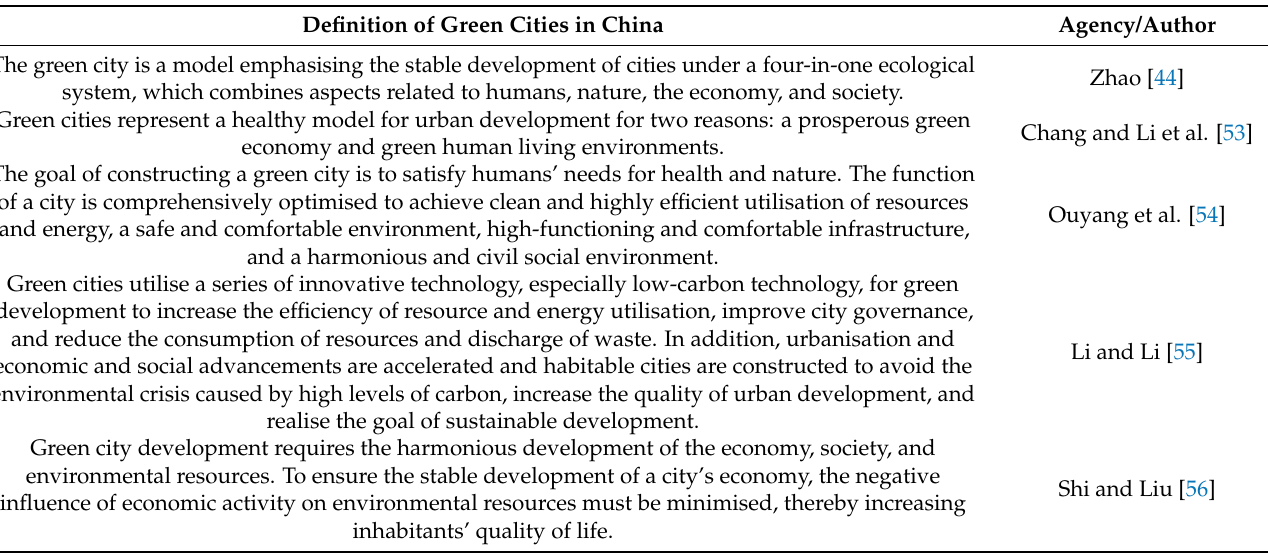
Table 2. Development of the concept of green cities in